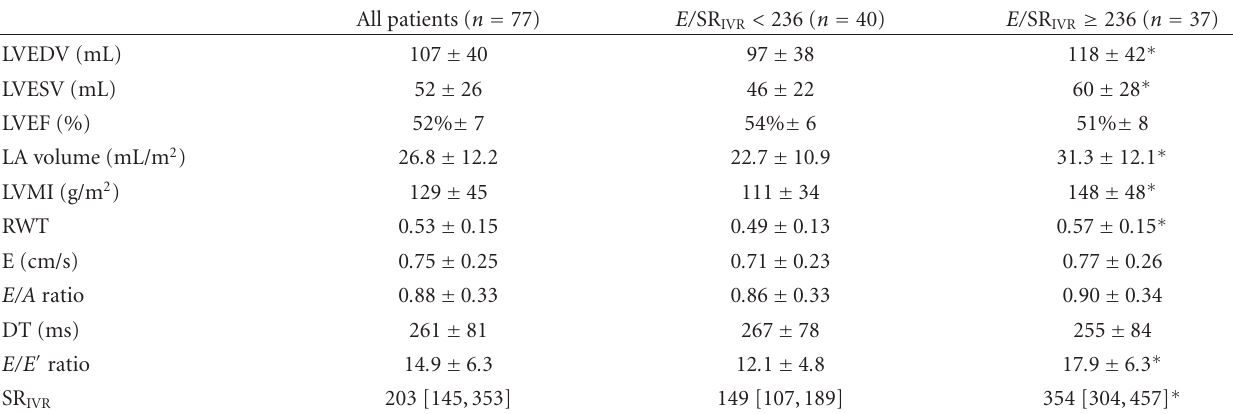
Table 2: Echocardiographic characteristics of the total patient population and divided according to the presence ( E/ SR IVR ≥ 236) or not ( E/ SR IVR < 236) of significant left ventricular diastolic